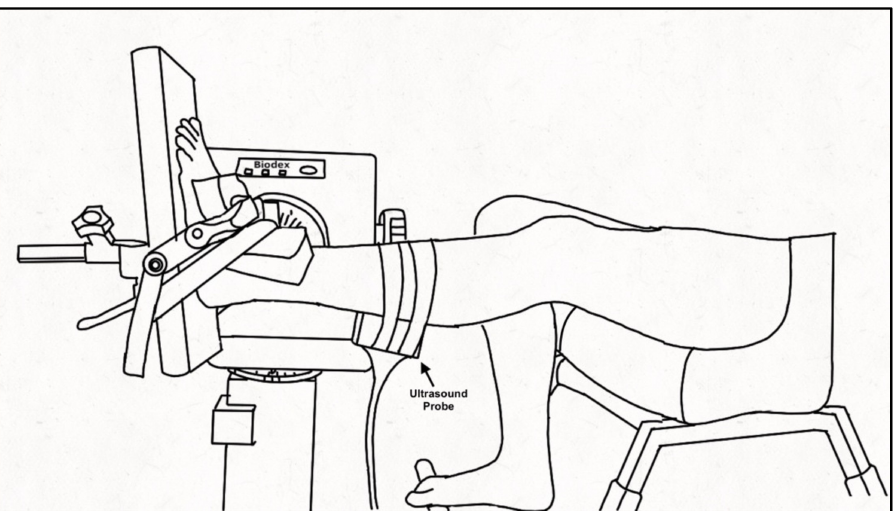
Figure 1. Experimental set-up. Schematic of participant seated in the Biodex dynamometer chair with the tested leg secured to the footplate of the dynamometer using inelastic straps. The ultrasound probe was encased in a customized probe holder and secured over the medial gastrocnemius using inelastic straps. The non-tested leg rested on a